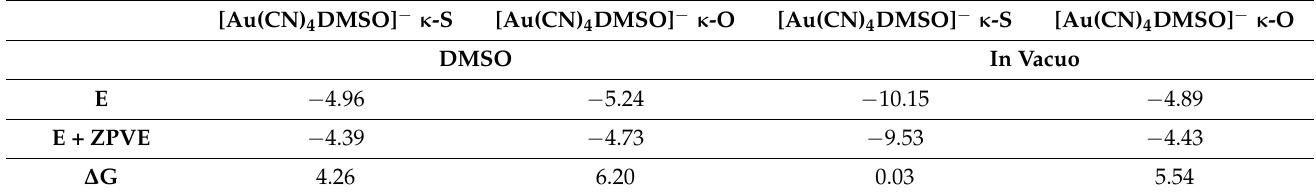
Table 4. Energy (E); energy corrected by the zero-point vibrational energy (E + ZPVE); Gibbs free energy ( ∆ G) of the complex formation of gold(III) tetracyanide dimethyl sulfide (1:1) complex. In vacuo—results obtained without solvation. DMSO—results obtained using PCM implicit solvation model. All values are in